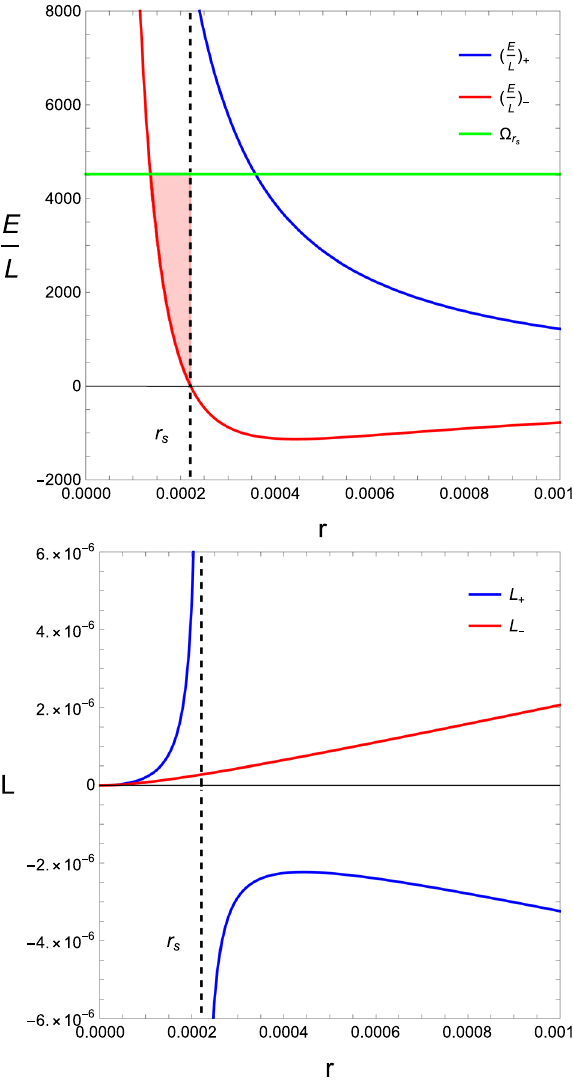
Fig. 4 E and L as the function of r for the upper and lower panel, L respectively. The forbidden regions in two plots are presented with the static limit at r s ≈ 221 µ m, and the parameters ξ = 695 µ m, (cid:2) r v θ = 4518 . 37 r s